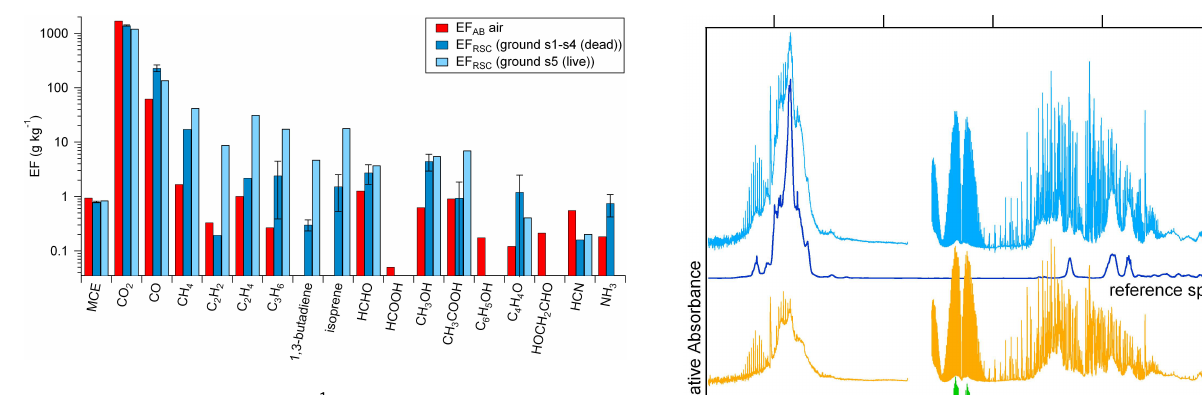
Fig. 3. Emission factors (g kg − 1 ) as measured from both the air- borne and ground-based FTIR for the ME burn of Camp Lejeune, 1 March 2010. AB=airborne, RSC=ground-based sampling.